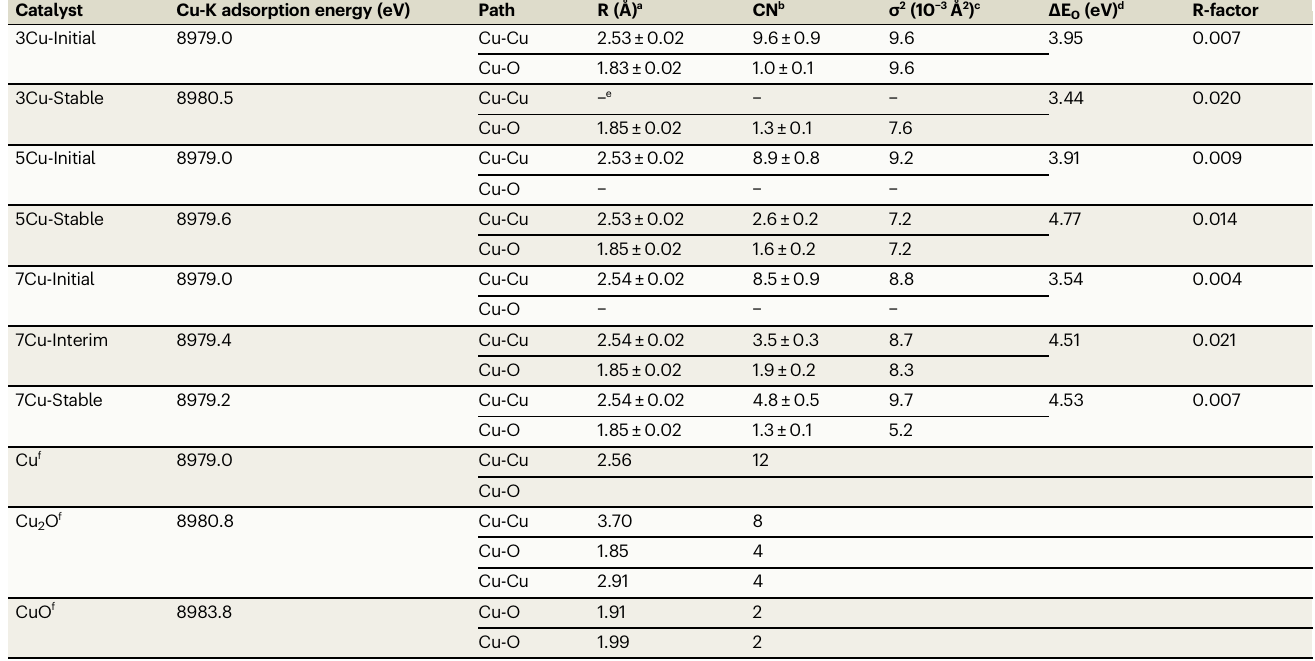
Table 1 | Cu-K adsorption energy and EXAFS fi tting results of Cu catalysts in the different stages Catalyst Cu-K adsorption energy